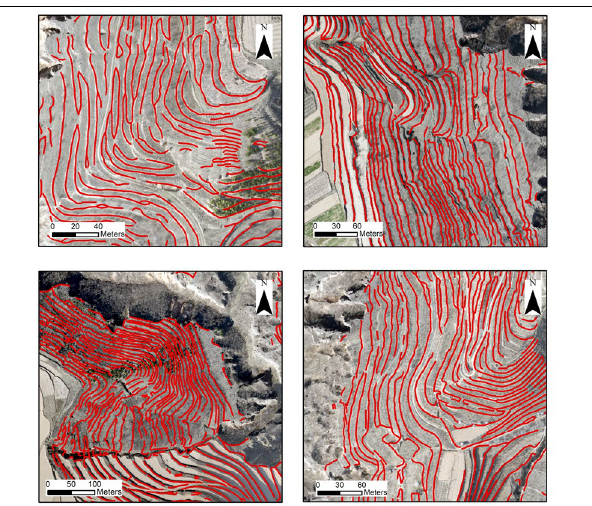
Figure 7. Extraction result in